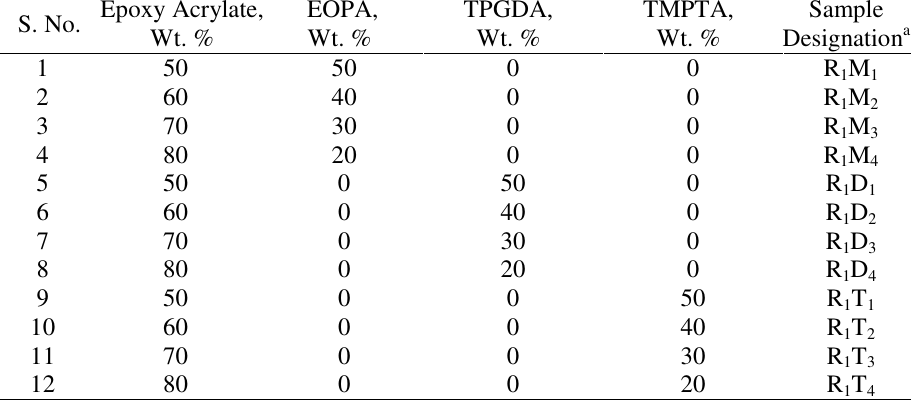
Table 1. Sample designation of various blend